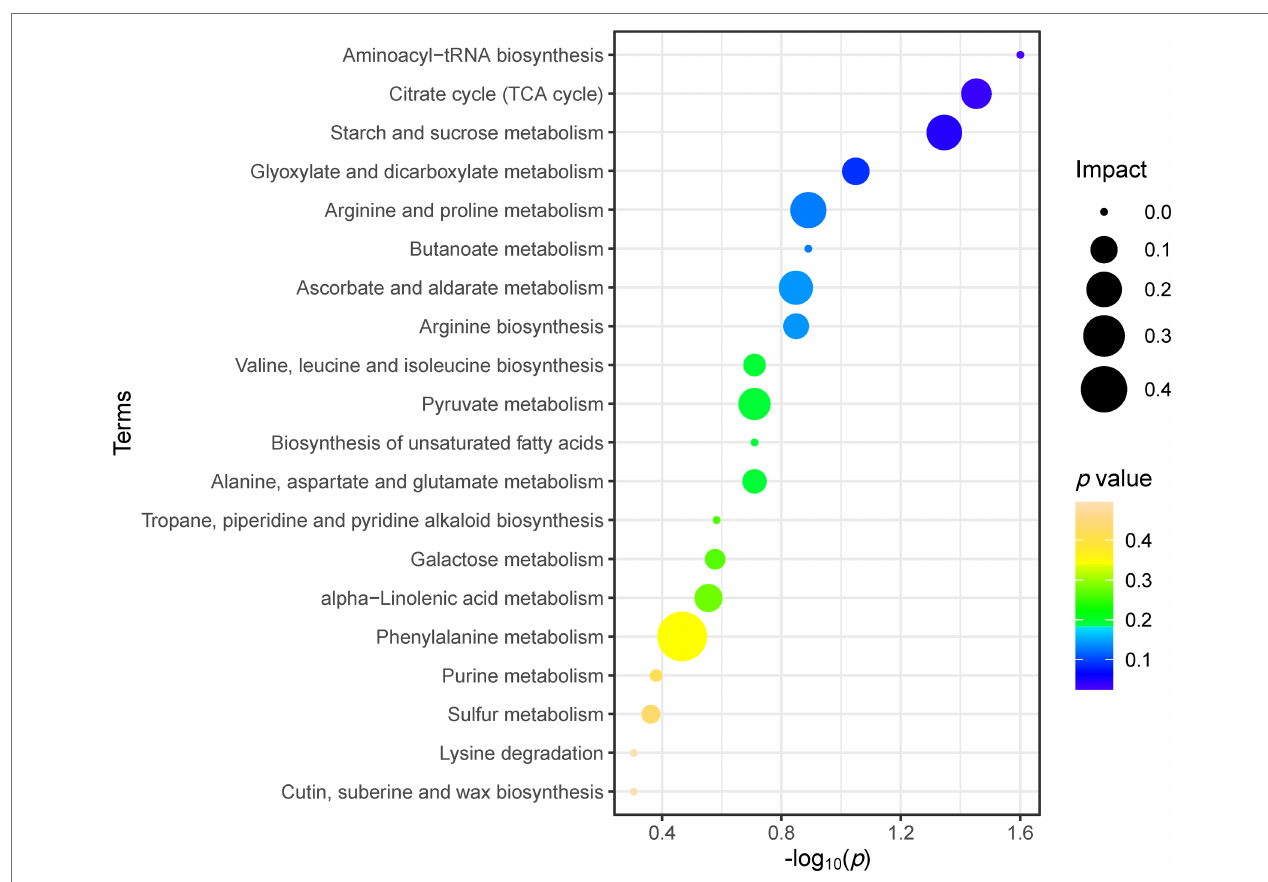
FIGURE 5 | Top 20 metabolic pathways of C. breviculmis affected by drought stress via pathway analysis from differential metabolites. The pathway impact is computed from the pathway topological analysis and represented via the circle size. The p values obtained from pathway enrichment analysis showed both by the x -axis ( − log10) and